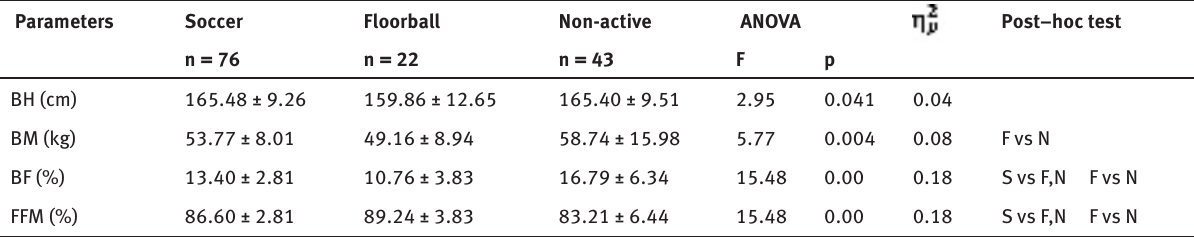
Table 1 : Differences in anthropometric and body composition parameters between groups